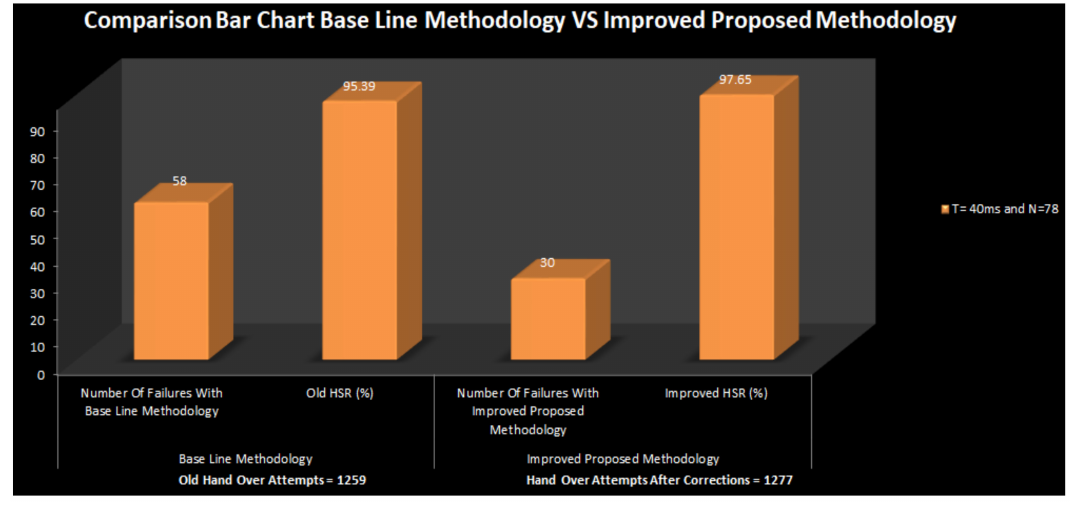
Figure 7. Comparison bar chart.